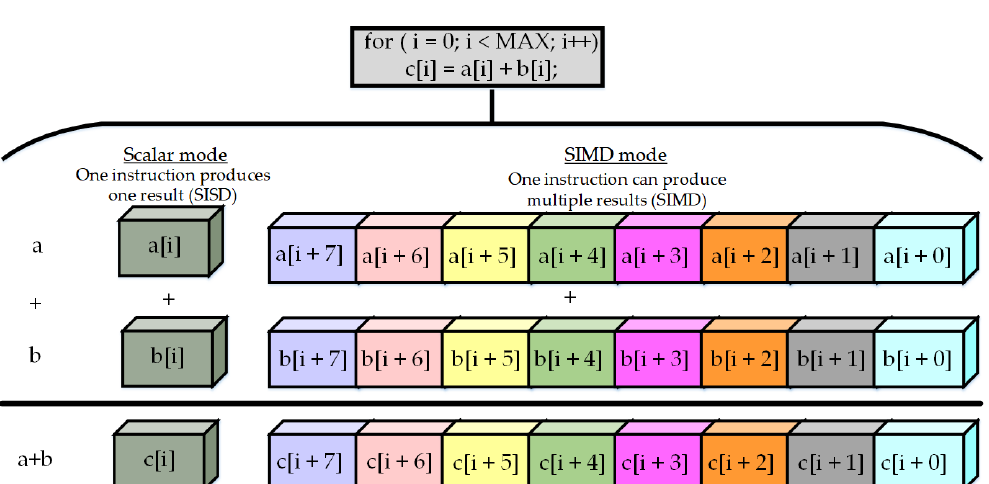
Figure 8. Single-instruction multiple-data (SIMD) operation.